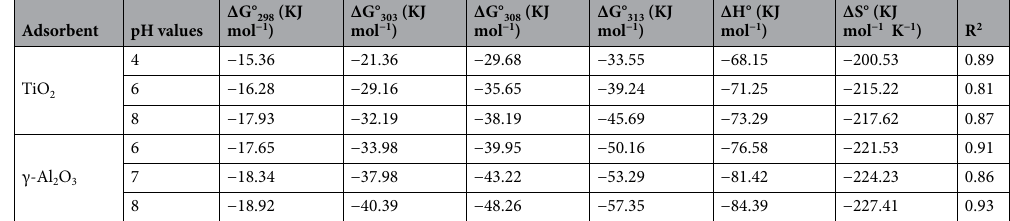
Table 6. Calculated thermodynamic parameters of Cu(II) adsorption on the nanoparticles at different pH values.